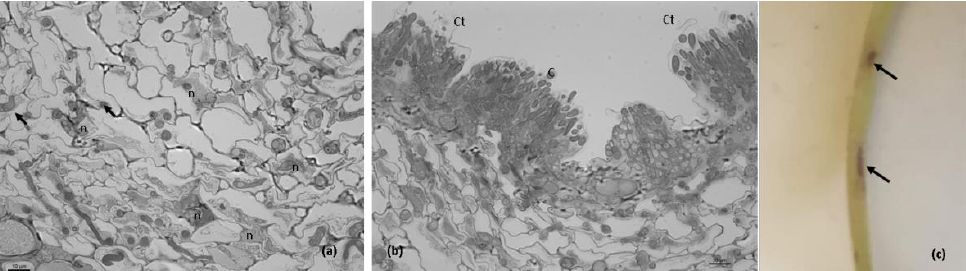
Figure 5. The Colletotrichum lupini infection process on petioles of Lupinus mutabilis and the corre- sponding macroscopic symptoms 6 days after inoculation. ( a , b ). Light microscopic observations, toluidine blue staining. ( a ). Dense fungal colonization of petiole cells, including the vascular system. Note the necrotized host cells (n) and their intense degradation and deformation. ( b ). Acervuli production, disruption of the petiole cuticle (Ct), and the release of conidia (C). ( c ). Petioles with dark sunken lesions (arrows). Scale bar = 10 µm.